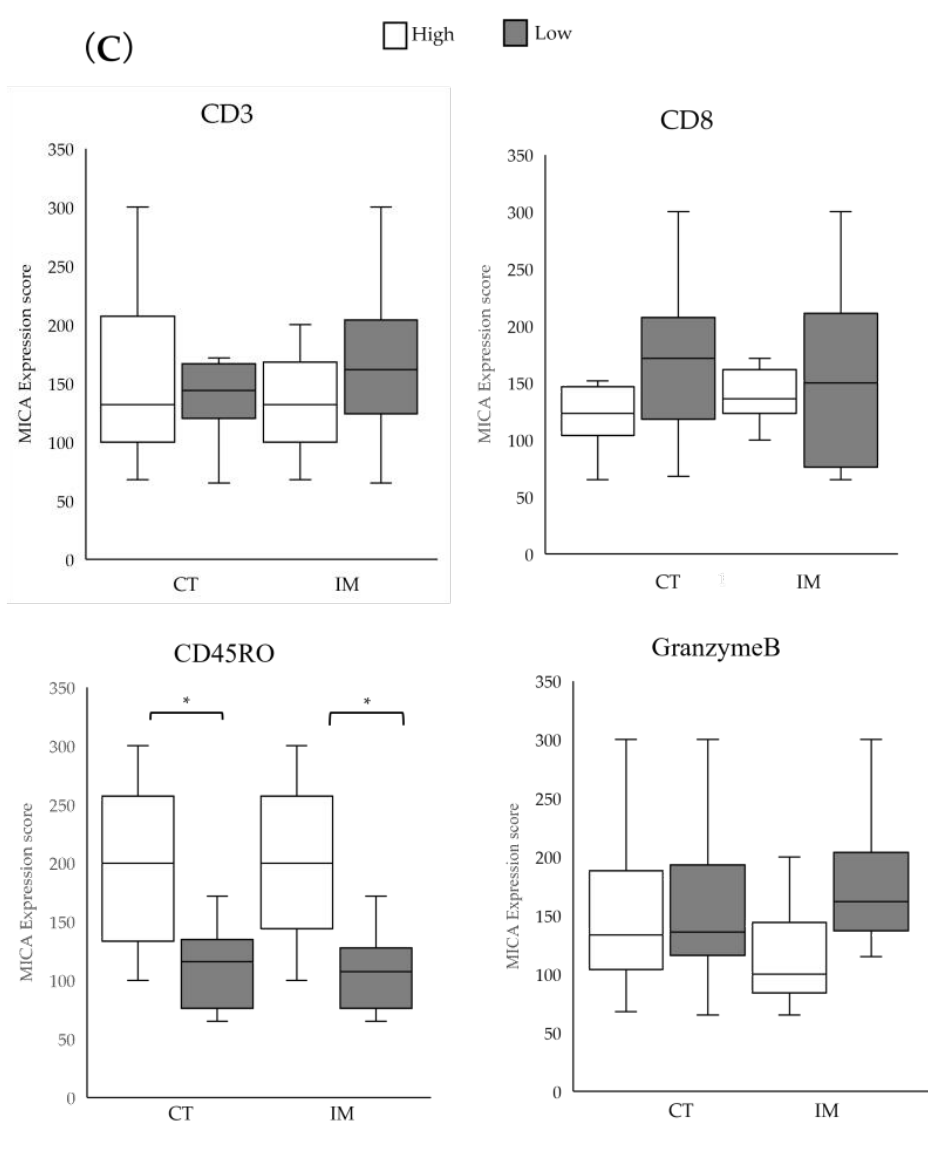
Figure 5. Comparison of the tumor MICA expression score between the TILs High and TILs Low groups. Differences in tumor MICA expression score in the TILs High and TILs Low groups were examined. Whole tumor cells were stained, showing representative examples of low ( A ) and high ( B ) expression (original magnification A and B × 400). The graph indicated the difference in tumor MICA expression scores in the CD3 + , CD8 + , CD45RO + , and Granzyme B + /TILs High and TILs Low groups in the CT and IM regions. In comparison, the tumor MICA expression scores in the CD45RO + /TILs High group were more significantly elevated than those in CD45RO + /TILs Low group ( C ). Differences were determined using the Mann–Whitney U test. * Statistically significant difference at p <